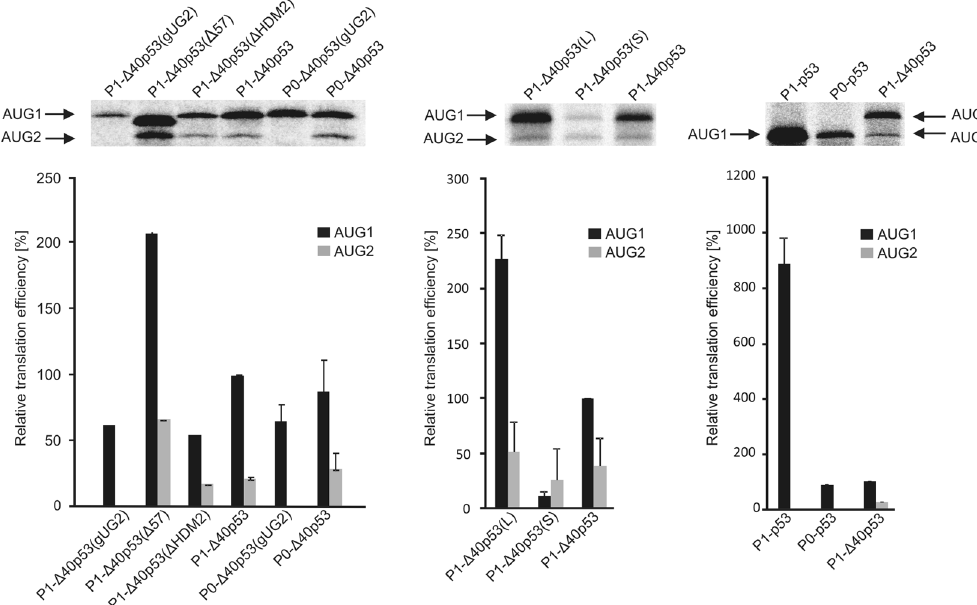
Figure 2. In vitro translation of the model mRNA constructs from AUG1 and AUG2 initiation codons performed in the rabbit reticulocyte lysate (RRL) system. The autoradiograms show the translation products and the bar charts quantitatively display the translation efficiency of model mRNAs from two initiation codons. All values are averages of at least three independent experiments and were normalized to the translation efficiency of product synthesized from AUG1 in P1- Δ 40p53 mRNA. The full-length autoradiograms were included in Suppl. Fig.